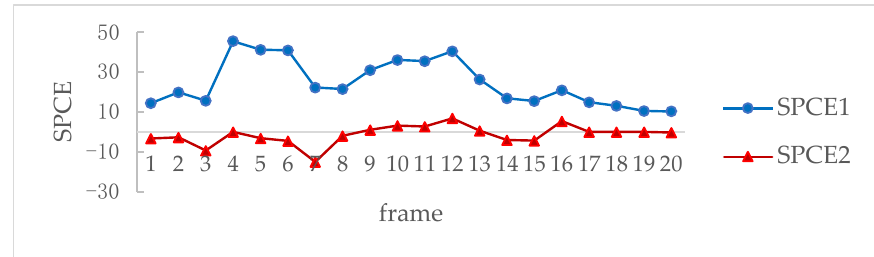
Figure 5. The values of SPCE between the forged area and RSPN.